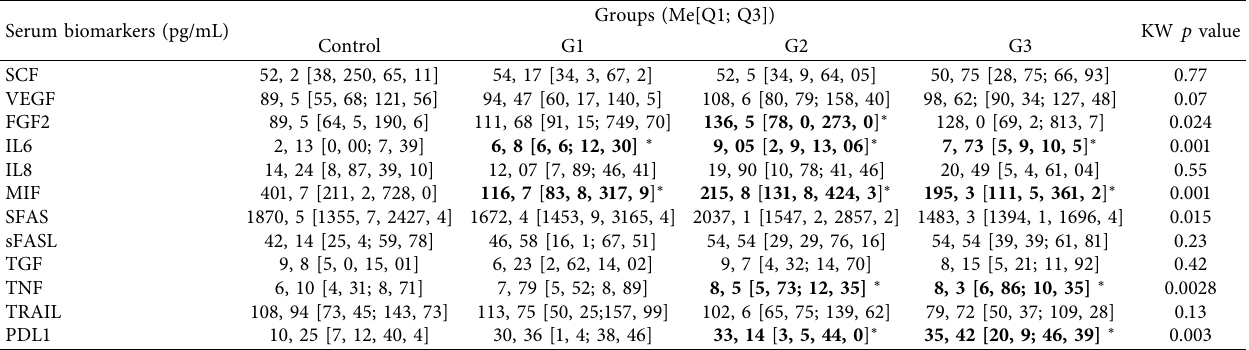
Table 2: The content of biomarkers in the studied